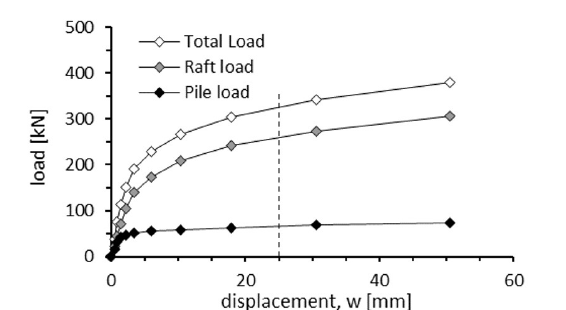
Figure 11. Load-settlement curves for case 4 - L=3m; t=0.4m